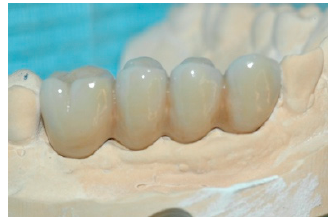
Prosthesis 2020 , 1 , FOR PEER REVIEW